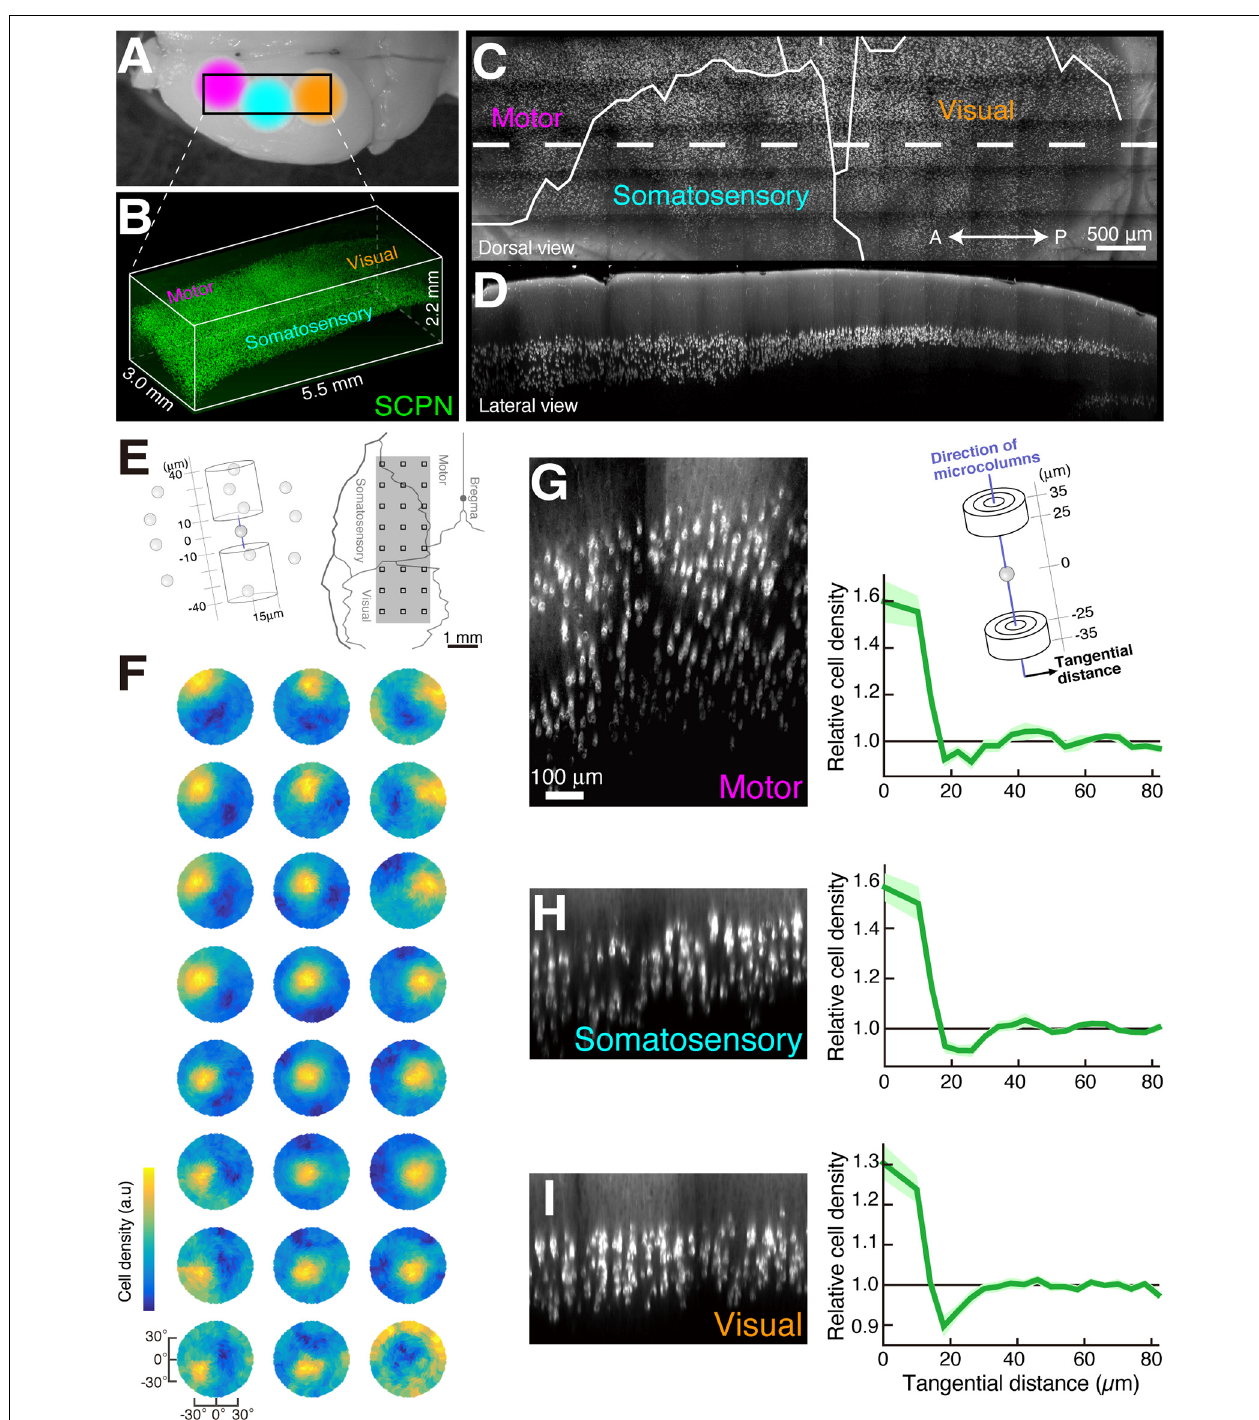
FIGURE 2 | Microcolumns are present in multiple cortical areas (modified from Maruoka et al., 2017). Dorsal image of mouse brain (A) and 3D image data of subcerebral projection neurons (SCPNs, B ). Dorsal image (C) and sagittal section image (D) of the white dotted area in (C) created from the image data in (B) . The determination of microcolumn axes (E,F) . We calculated the cell density of other SCPNs within two cylinders centered on the reference SCPNs ( E , left). This calculation was performed within cylinders tilted at various angles, and the direction with the highest cell density was identified (F) . The squares in the right panel of (E) match the 3 × 8 data positions (F) . Cortical sections showing SCPNs (G–I) generated along the microcolumn axis identified in ( F , left) and graphs showing the relationship between relative cell density of SCPNs and intercellular distance in the tangential orientation (perpendicular to the microcolumn axis). Cell densities were calculated in the two cylinders illustrated in (G)